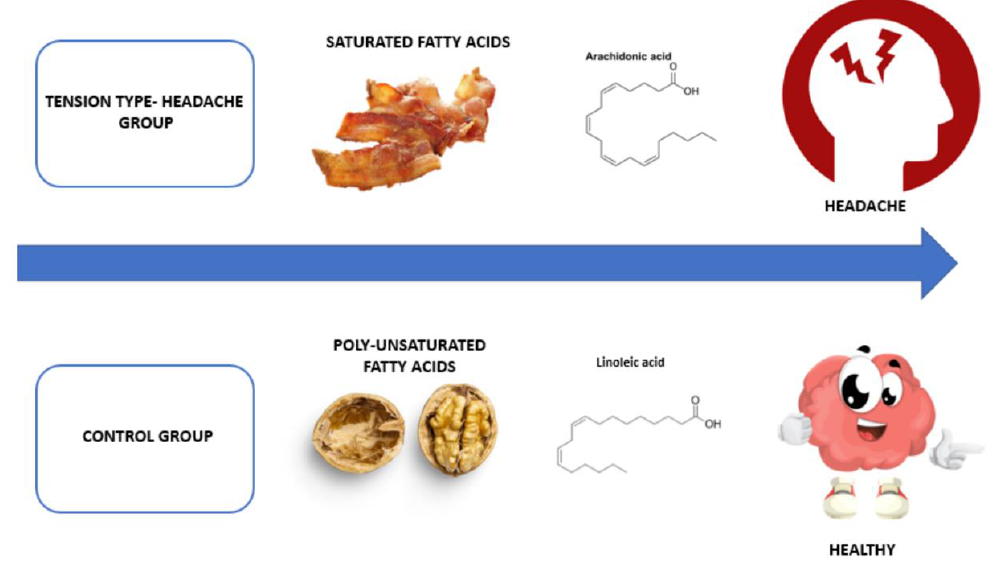
Figure 1. Relationship between saturated and poly-unsaturated fatty acids with tension-type headache.